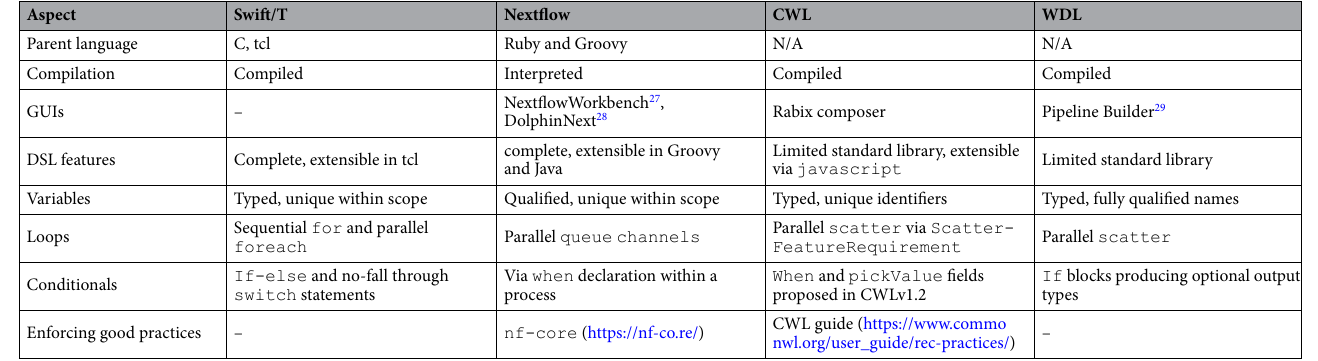
Table 1. Summary of language-level differences among Swift/T, Nextflow, CWL and